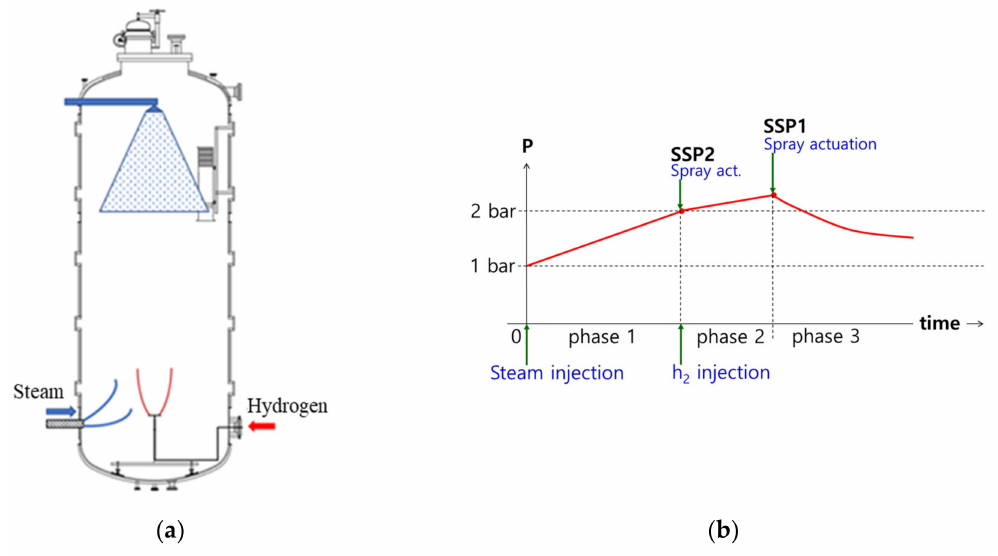
Figure 8. SPARC-SPRAY-PAR (SSP1) experiment: ( a ) Configuration of flows inside vessel; ( b ) Test conditions step by